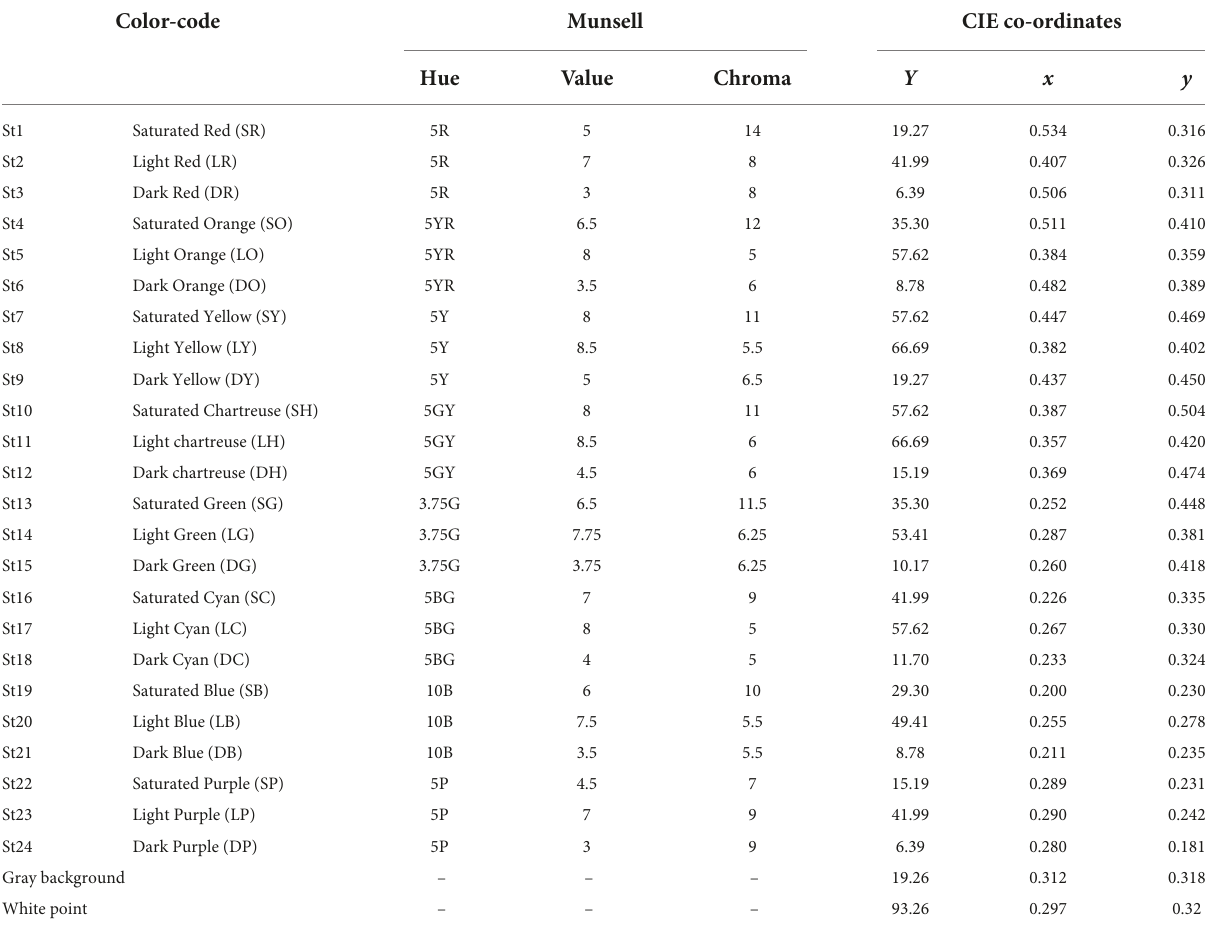
TABLE 1 Coordinates in Munsell color space and the CIE (1932) Y,x,y chromaticity coordinates for the twenty-four colors and the gray background and white point of the monitor.